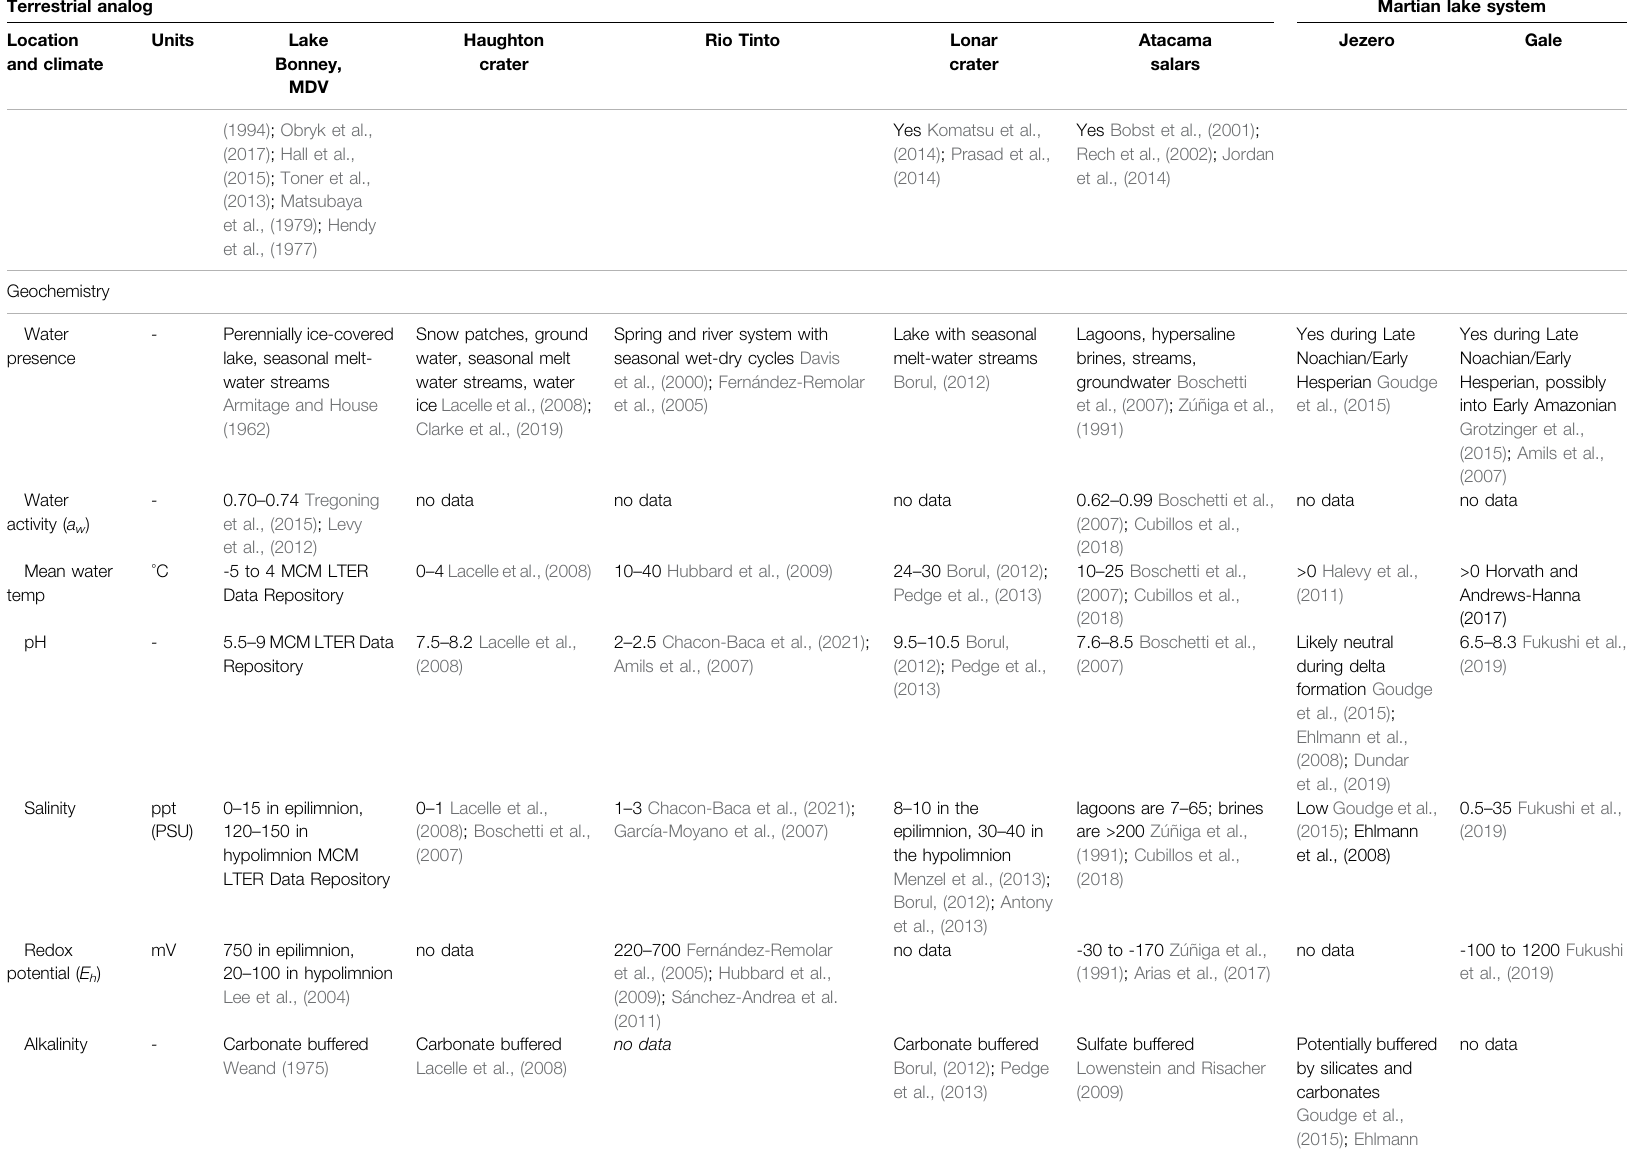
TABLE 1 | ( Continued ) A cross-site comparison of selected environmental, mineralogical, chemical, and biological